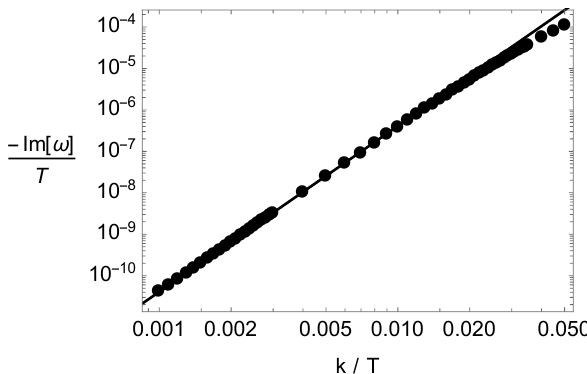
Figure 21 . The dispersion relation of the subdiffusive mode at finite density ( µ/T = 0 . 5) and B/T 2 = 0 . The solid line is the prediction from first-order magnetohydrodynamics presented in the main text.